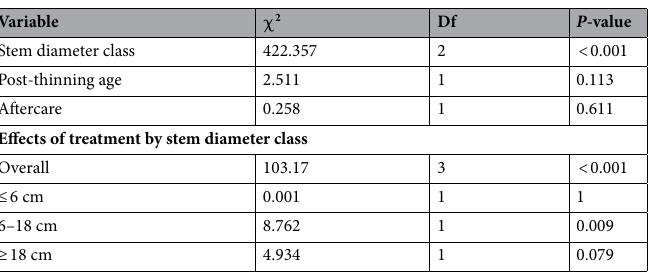
Table 8. Hypothesis tests of the estimated generalized linear mixed-effects model (GLMM) model coefficients showing overall treatment effects and differences in the abundance of encroacher species in stem